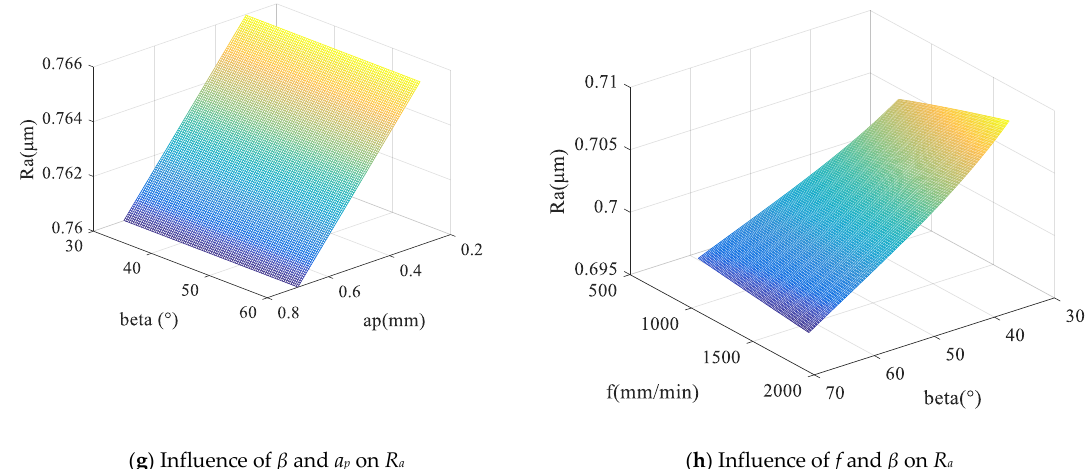
Figure 15. Cross-factor analysis for R a.